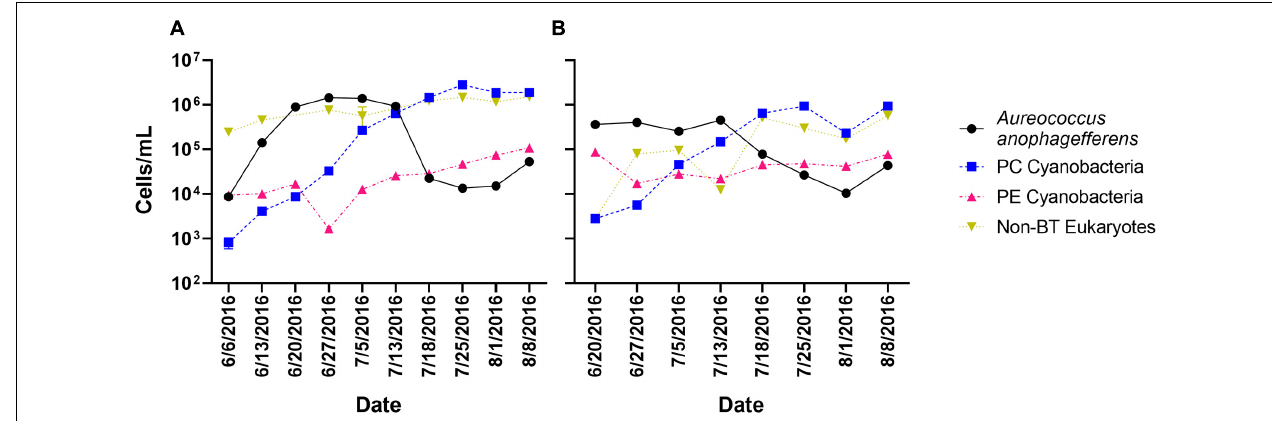
FIGURE 1 | Cell concentrations over the sampling period in (A) Quantuck Bay and (B) Tiana Beach. PC Cyanobacteria: phycocyanin-containing cyanobacteria; PE Cyanobacteria: phycoerythrin-containing cyanobacteria; non-BT Eukaryotes: non– A. anophagefferens eukaryotes. Error bars represent ± SD and, where not visible, are within the size of the